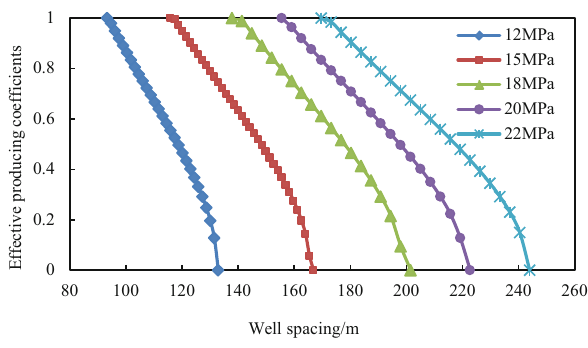
Fig. 13 Effective producing coefficient of different injection/pro- duction pressure Table 1 Well spacing calculated by two methods Injection/production pressure